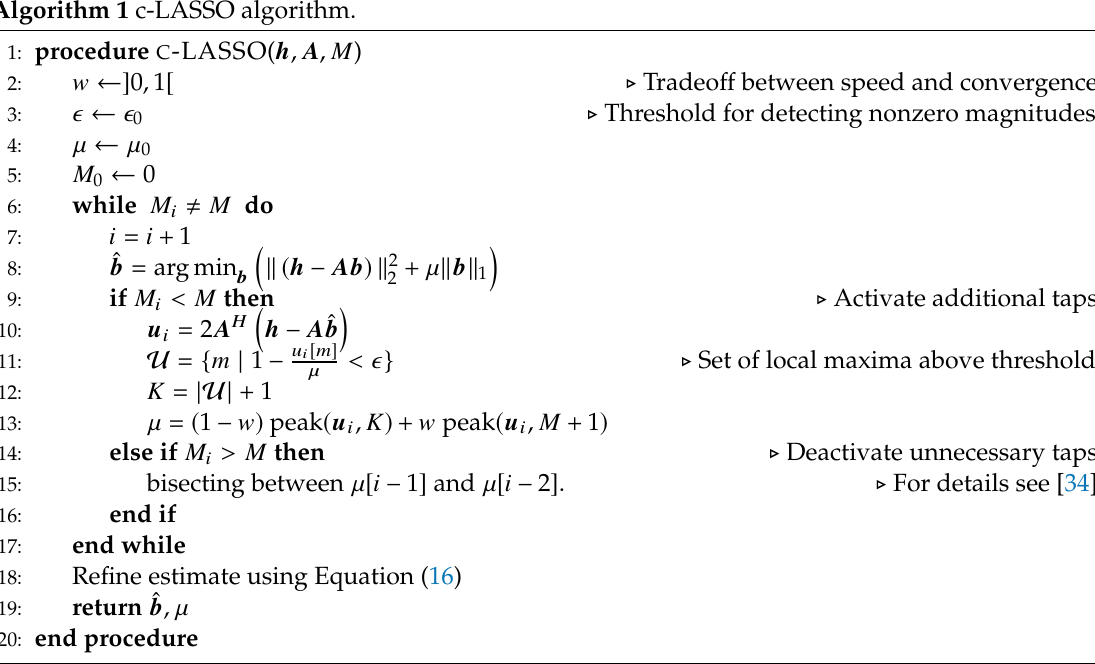
Algorithm 1 c-LASSO